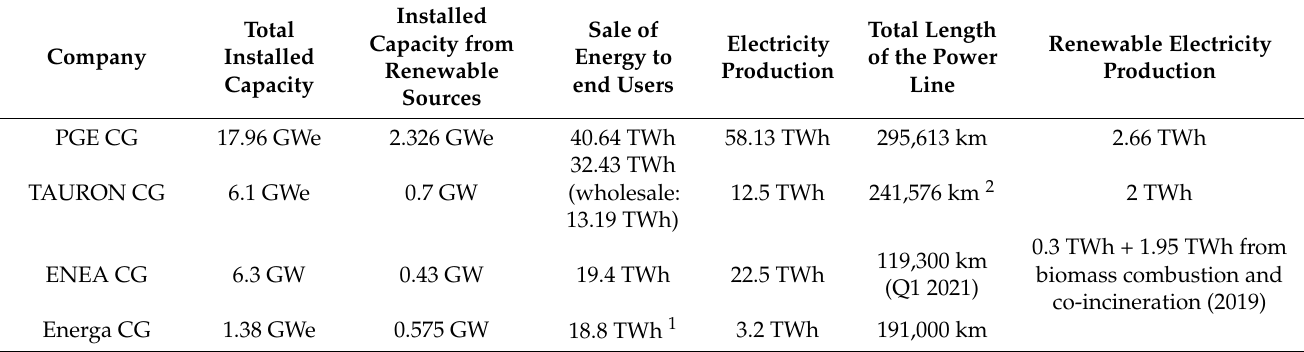
Table 5. Characteristics of the leading capital groups generating electricity in Poland